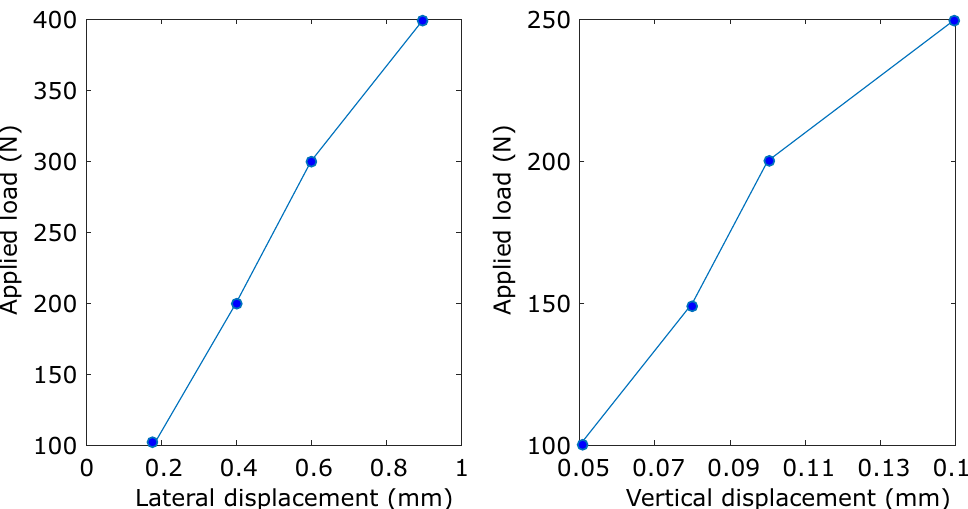
Figure 16. Mechanism support lateral (left) and vertical (right) displacement measured at the middle of the bridge when different loads are